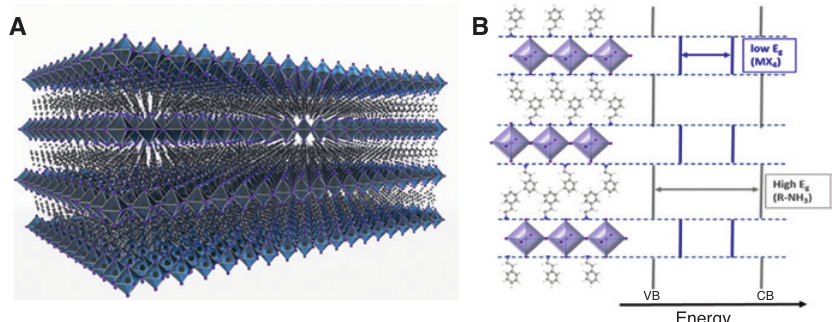
Figure 4: Structure of 2D PVK. (A) Sketch of a 2D PVK superlattice consisting of lead iodide inorganic layers sandwiched between interdigitating alkylammonium cations [55]. (B) Schematic energy band structure of a 2D